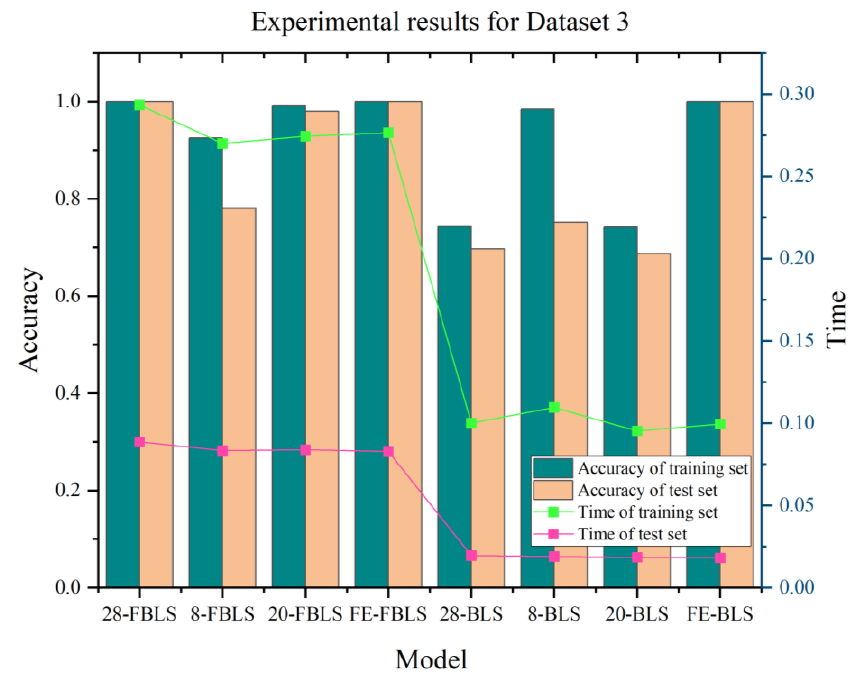
Figure 13. Experimental results of different features on dataset 3.